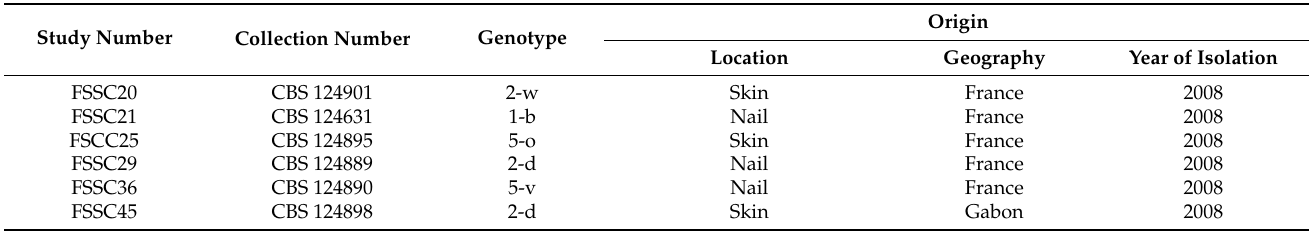
Table 1. Characteristics of the Fusarium solani species complex strains used in this